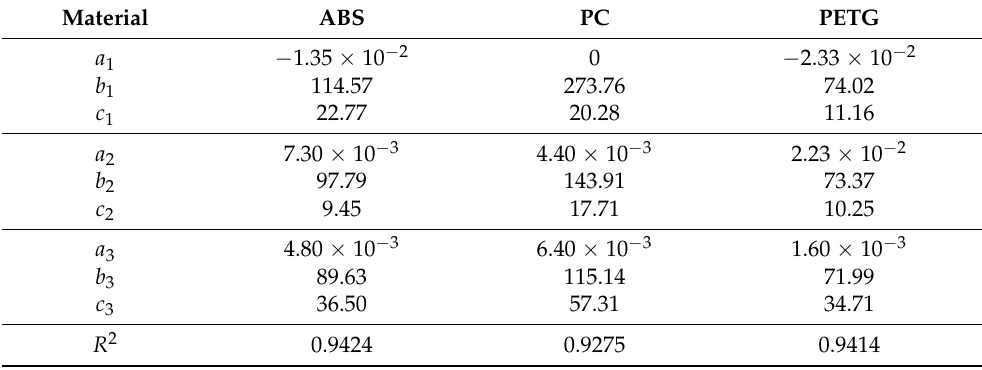
Table A4. Gaussian fitting parameters for neat materials.